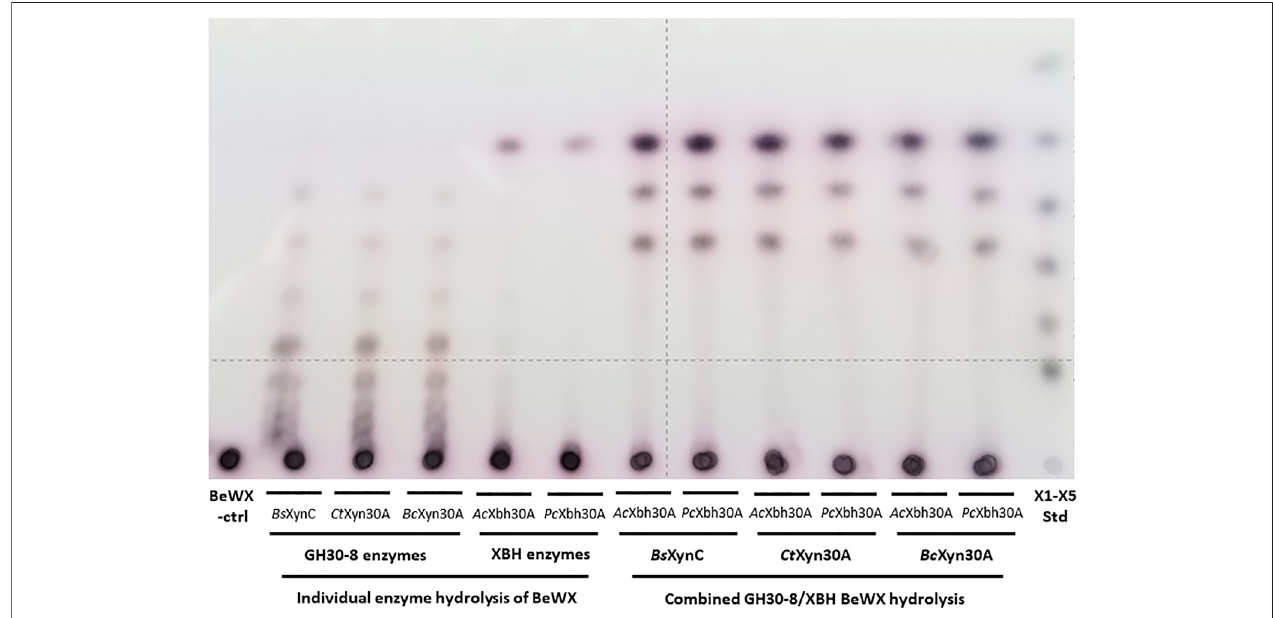
FIGURE 6 | TLC analysis verifying function of three canonical functioning GH30-8 glucuronoxylanases Bs XynC (St John et al., 2006a), Ct Xyn30A (St John et al., 2017), and Bc Xyn30A (unpublished) and the newly identi fi ed xylobiohydrolase Ac Xbh30A-CD [this work and Š uchová et al. (2020a)] as well as its homolog Pc Xbh30A (this work) in the hydrolysis of polymeric glucuronoxylan. When combined, these enzymes convert glucuronoxylan to the three products X 2 , GX, and XGX ( Supplementary Figures S1D – F ,